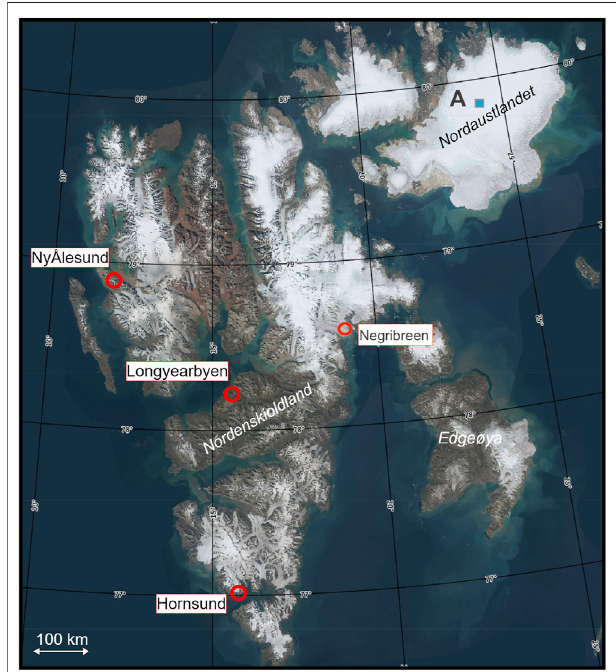
FIGURE 1 | The Svalbard archipelago, with the locations of Hornsund, Longyearbyen, and Ny Ålesund indicated. Meteorological data measured at these sites have been used in this study. In addition, we have presented backscatter data from a small area (A) on Austfonna (79.86 ° N, 24.39 ° E). This fi gure has been obtained courtesy of the Norwegian Polar Institute. Retrieved from https://toposvalbard.npolar.no on 18 January